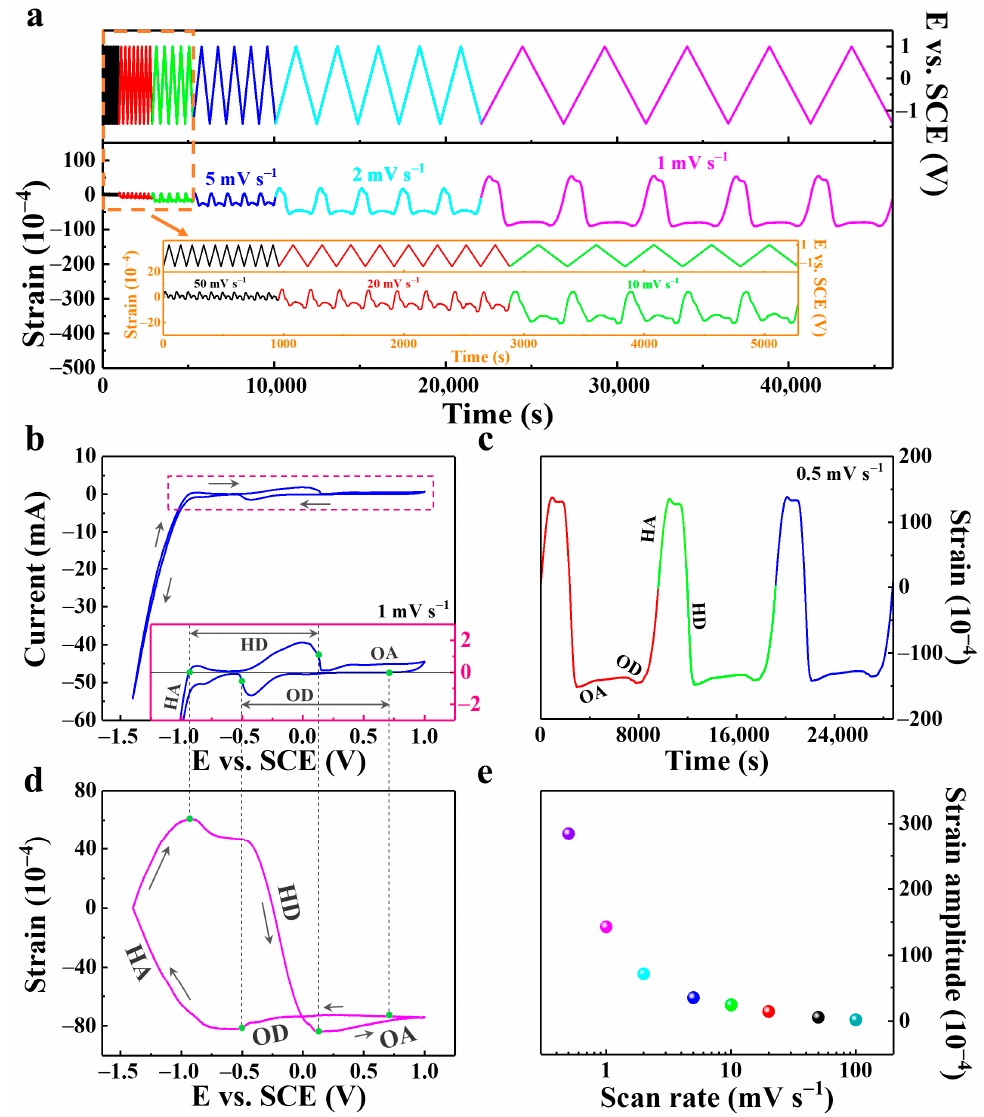
Figure 10. ( a ) CV-induced strain of the bulk np-Pd in 0.7 M NaF at different scan rates from 50 to 1 mV s − 1 . ( b ) CV curve at the scan rate of 1 mV s − 1 and an enlarge region for displaying details. ( c ) Successive strain response at the scan rate of 0.5 mV s − 1 . ( d ) Strain as a function of the applied potential at the scan rate of 1 mV s − 1 . ( e ) Strain amplitude versus the scan rate.